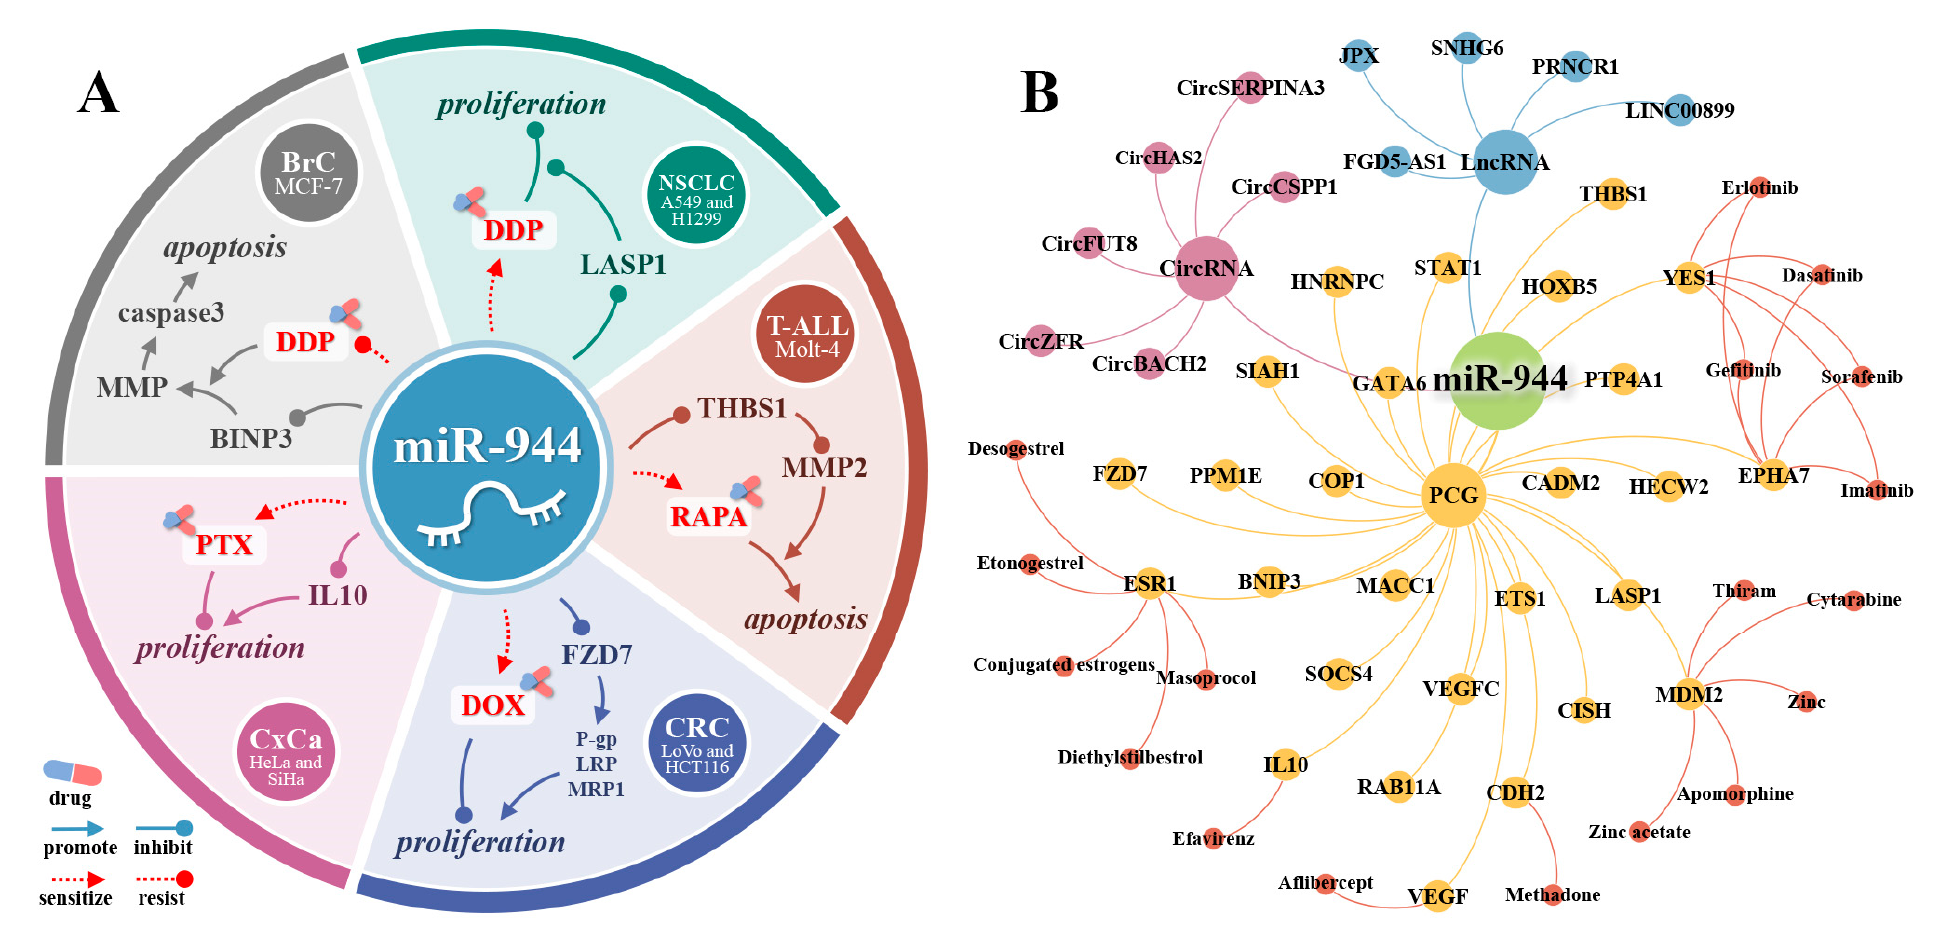
Figure 7. The miR-944-related therapeutic drugs. ( A ) miR-944 is associated with resistance to 4 drugs (DDP, RAPA, DOX, and PTX); ( B ) the target drugs of miR-944 ′ s PCGs and the ceRNA/miR-944/PCG axes in the CADDIE database.